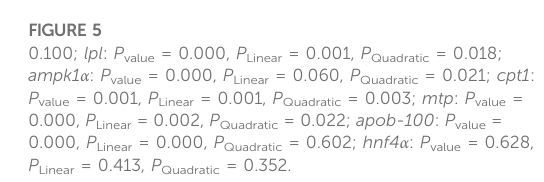
FIGURE 5 0.100; lpl : P value = 0.000, P Linear = 0.001, P Quadratic = 0.018; ampk1 α : P value = 0.000, P Linear = 0.060, P Quadratic = 0.021; cpt1 : P value = 0.001, P Linear = 0.001, P Quadratic = 0.003; mtp : P value = 0.000, P Linear = 0.002, P Quadratic = 0.022; apob-100 : P value = 0.000, P Linear = 0.000, P Quadratic = 0.602; hnf4 α : P value = 0.628, P Linear = 0.413, P Quadratic =